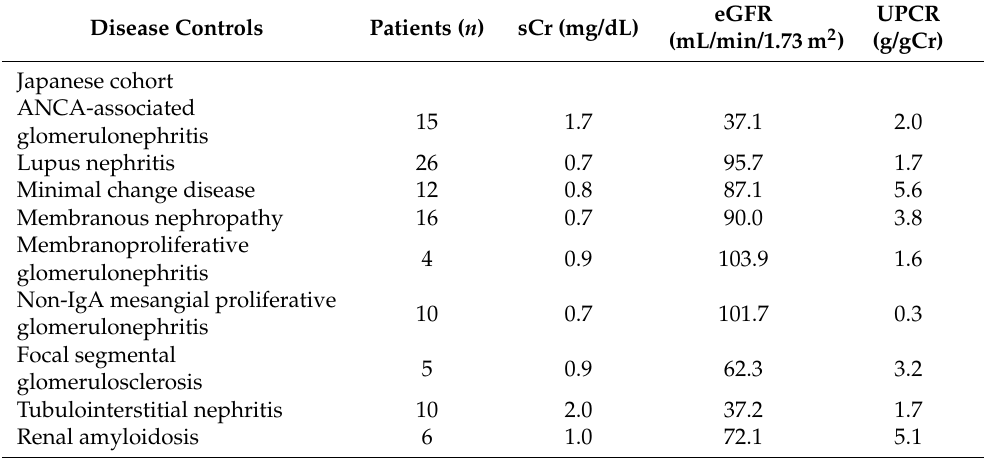
Table 2. Clinical characteristics of disease control patients from the Japanese and Korean